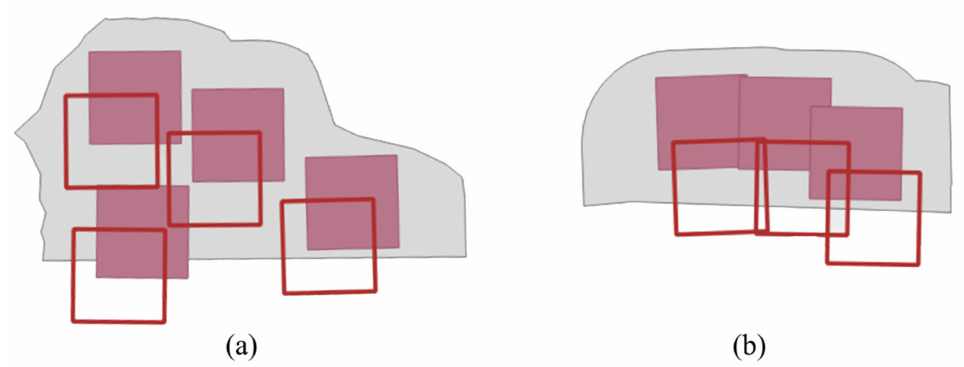
Figure 7. Buildings before (unfilled) and after (filled) toward-center displacement. The conflicts between buildings and roads: ( a ) reduced, ( b ) resolved.